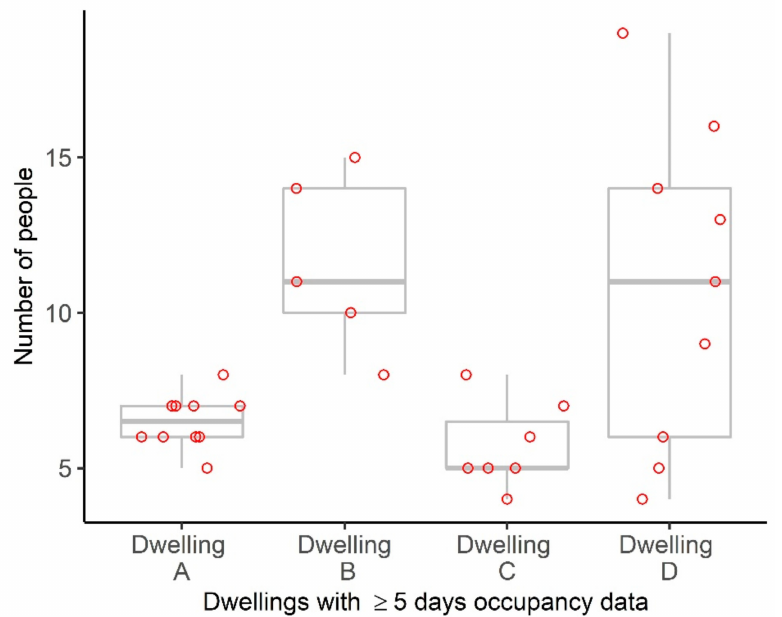
Figure 3. Distribution of the number of people per dwelling for dwellings with five or more nights of data. Each dot represents the total number of individuals in each dwelling for a specific survey response. The median is represented using the thick grey line and the interquartile range with the thinner grey